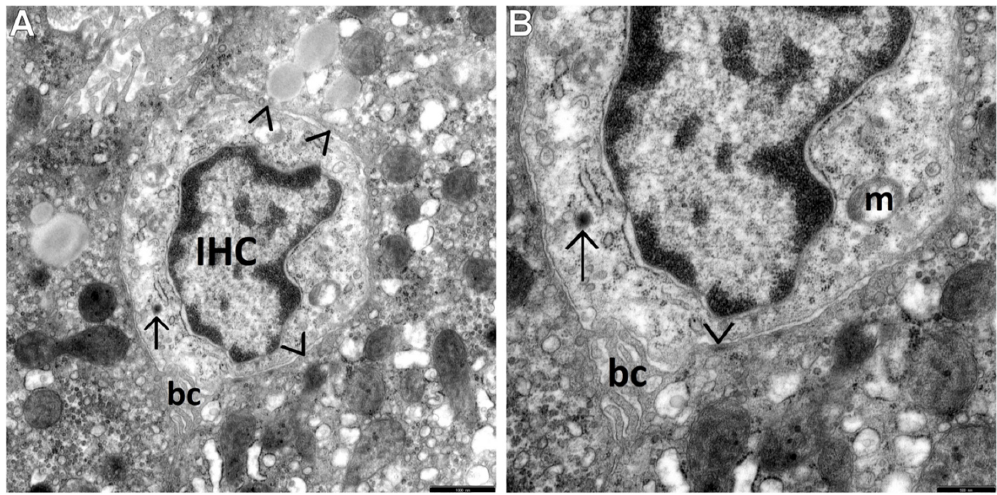
Figure 3. The view of a small (although bigger than the UPC) oval progenitor cell, markedly differentiating towards the hepatocyte lineage, i.e., an intermediate hepatocyte-like cell (IHC) in a liver biopsy obtained from a child with AIH. ( A ) IHC contains primitive-looking cytoplasmic structures in the electron-light cytoplasm (more numerous, however, as compared to the UPC in Figure 2). The cell organelles (better visualized in Figure 3B) include single mitochondria, very short channels of the granular endoplasmic reticulum, a small round structure that could correspond to a newly formed peroxisome ( → ) and glycogen rosettes; hemicanaliculus (i.e., an almost formed biliary canaliculus) is clearly seen—bc. The cell shows a high nucleus/cytoplasm ratio and a marginal location of heterochromatin. Hepatocytes that surround the IHC show features of acinar proliferation of the smooth endoplasmic reticulum. Point desmosomes (>) between the IHC and the adjacent hepatocyte. Scale bar: 1 µ m. ( B ) Higher magnification of the IHC well demonstrates the picture of primitive organelles, including a mitochondrion (m) and an already nearly formed biliary canaliculus (bc) located at the bottom pole of the cell. Scale bar: 0.5 µ